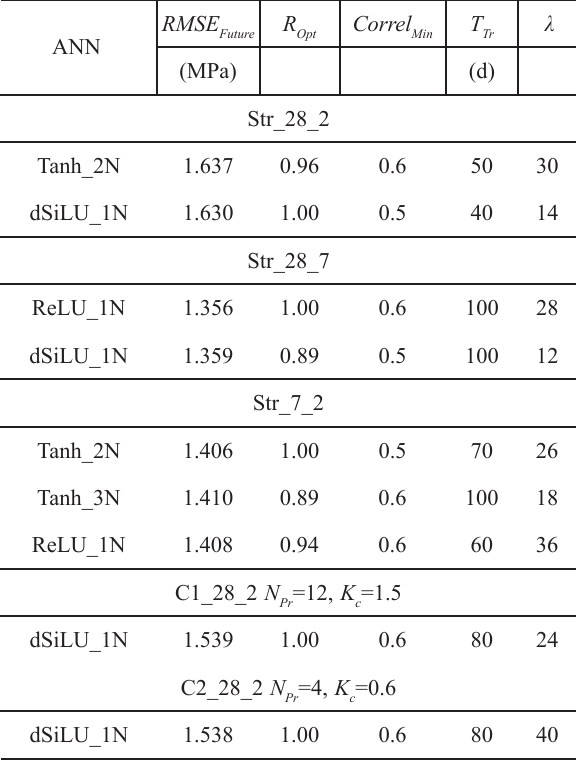
Table 6 – Optimal ANNs and parameters for each of the